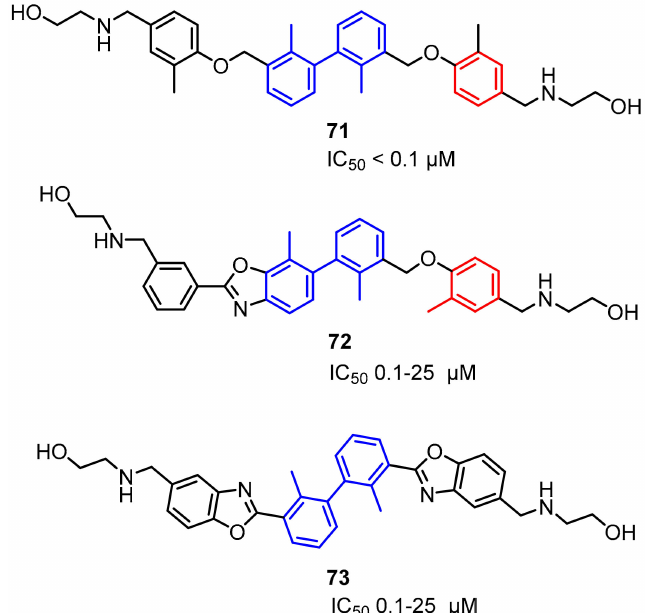
Figure 30. Examples of the structures patented by Arising International LLC.